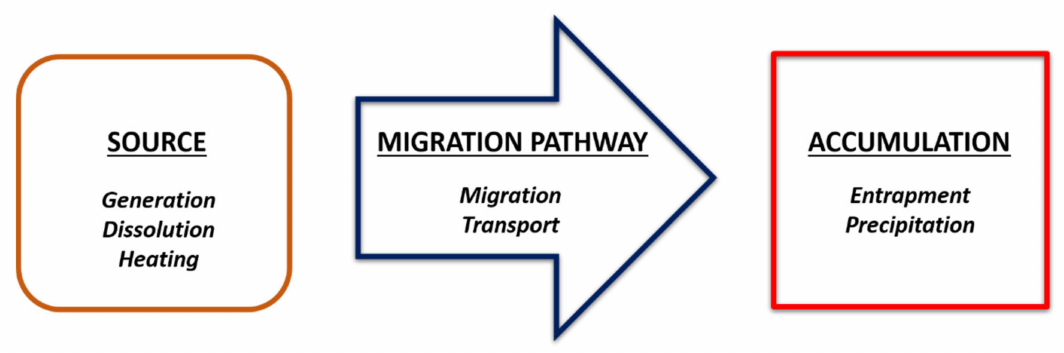
Figure 2. Major ELEMENTS and Processes of petroleum, mineral and geothermal